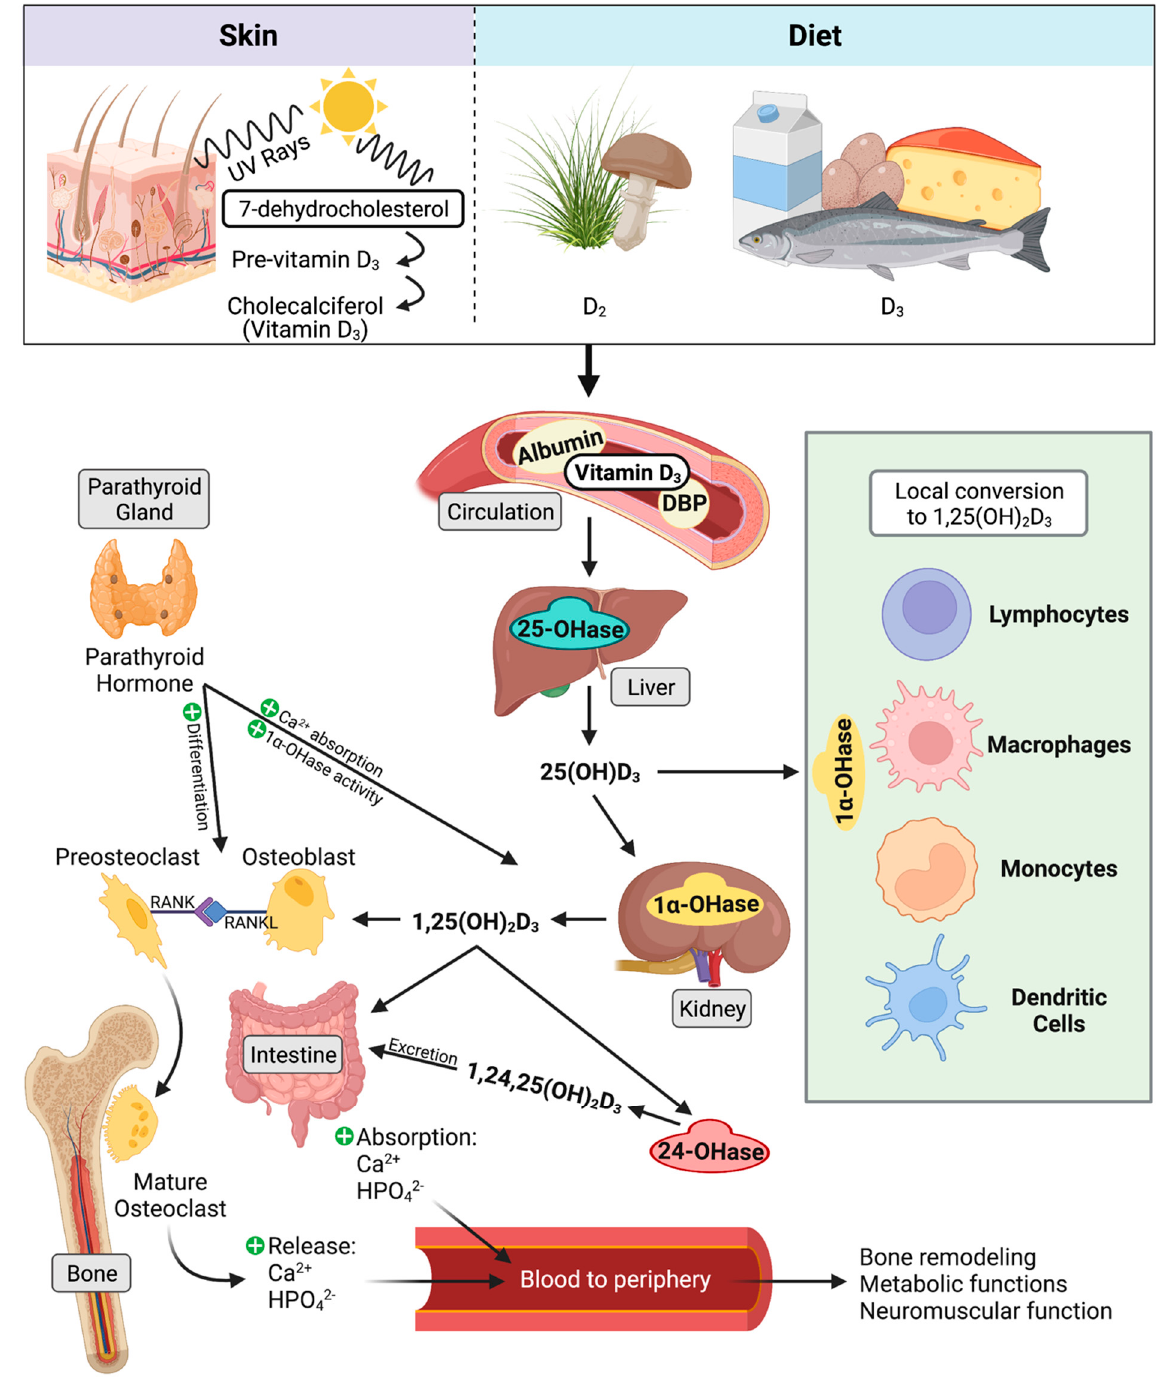
Figure 1. Vitamin D is synthesized in the skin or obtained from the diet. The most common and more potent form, vitamin D 3 , is focused on in this review. Vitamin D 3 is converted to 25(OH)D 3 in the liver. Classical effects on calcium homeostasis begin in the kidney, where 25(OH)D 3 is converted to bioactive 1,25(OH) 2 D 3 . 1,25(OH) 2 D 3 increases osteoclast differentiation and activation, and upregulates calcium and phosphate absorption in the gut. Concurrently with 1,25(OH) 2 D 3 , parathyroid hormone stimulates osteoclasts. It additionally upregulates 1 α –OHase (CYP27B1) activity and calcium reabsorption in the kidney. 25(OH)D 3 and 1,25(OH) 2 D 3 are both inactivated by 24–OHase (CYP24A1) and are excreted in the bile. Non-classical signaling of vitamin D 3 involves local activation of 25(OH)D 3 to 1,25(OH) 2 D 3 by 1 α –OHase (CYP27B1) in cells of the immune system. Figure created using BioRender.com (accessed on 28 July 2022).